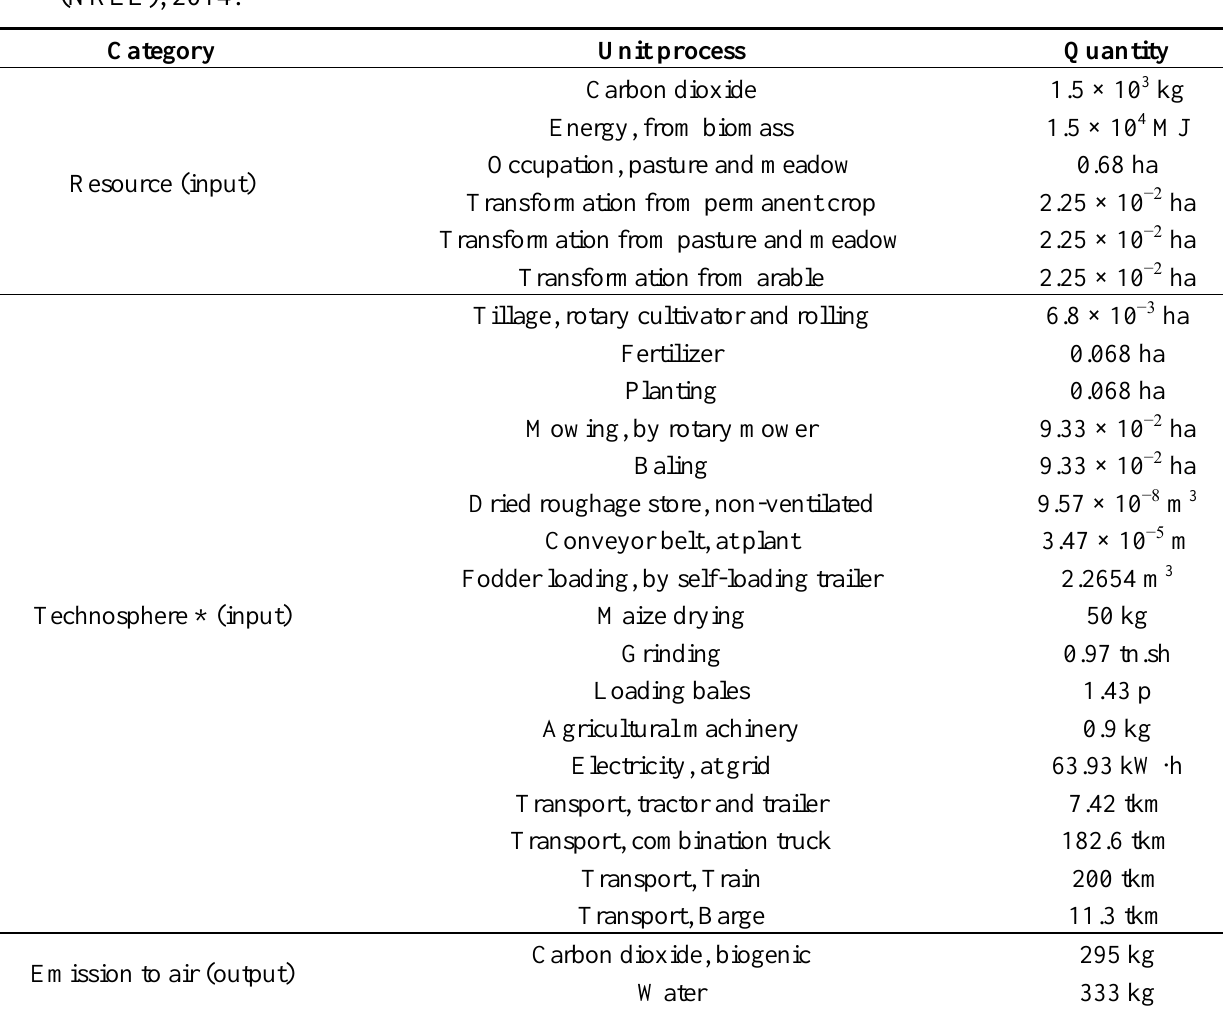
2. Inventory data for 1 ton switchgrass feedstock production